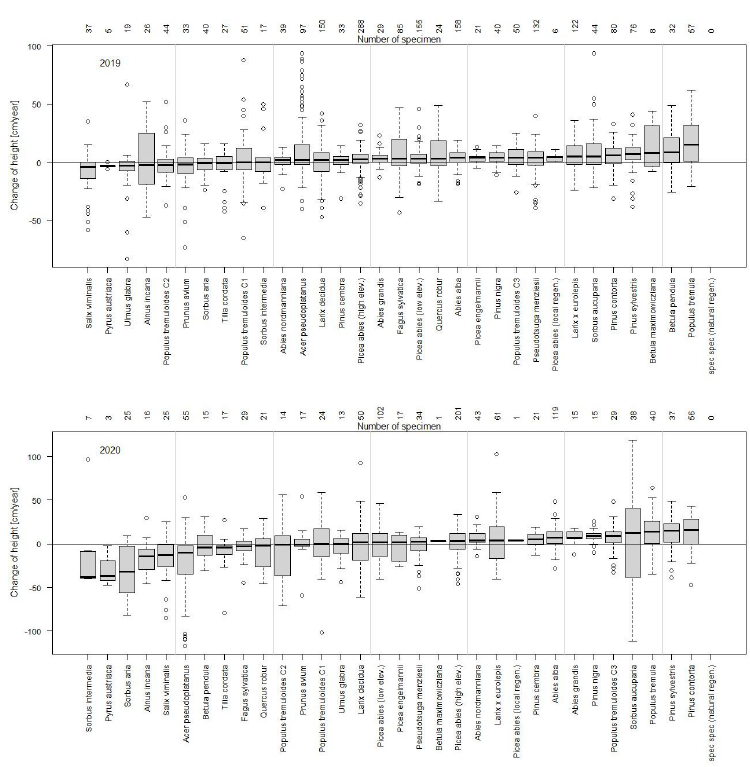
Figure 5. Annual height increment of trees in the reforestation experiment, Wechsel, in 2019 and 2020. The number of assessed seedlings is shown at the